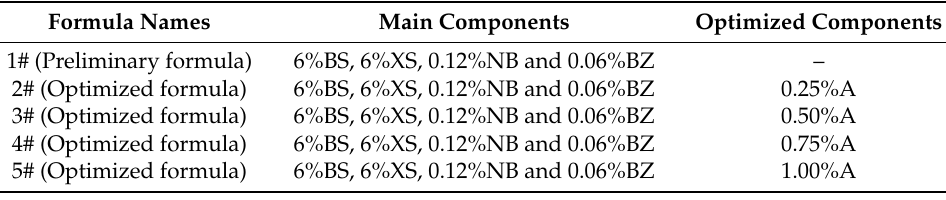
Table 5. Optimization design table for preliminary formula.